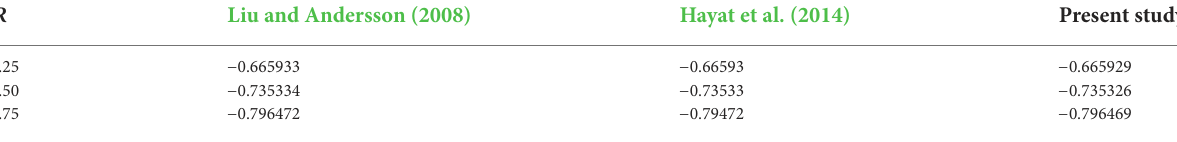
TABLE 2 An assessment table for − θ ′ (0) for pertinent ranges of R in reducing case when β 1 = β 2 = δ = β t = N t = N b = 0 and Pr = 1 . R Liu and Andersson